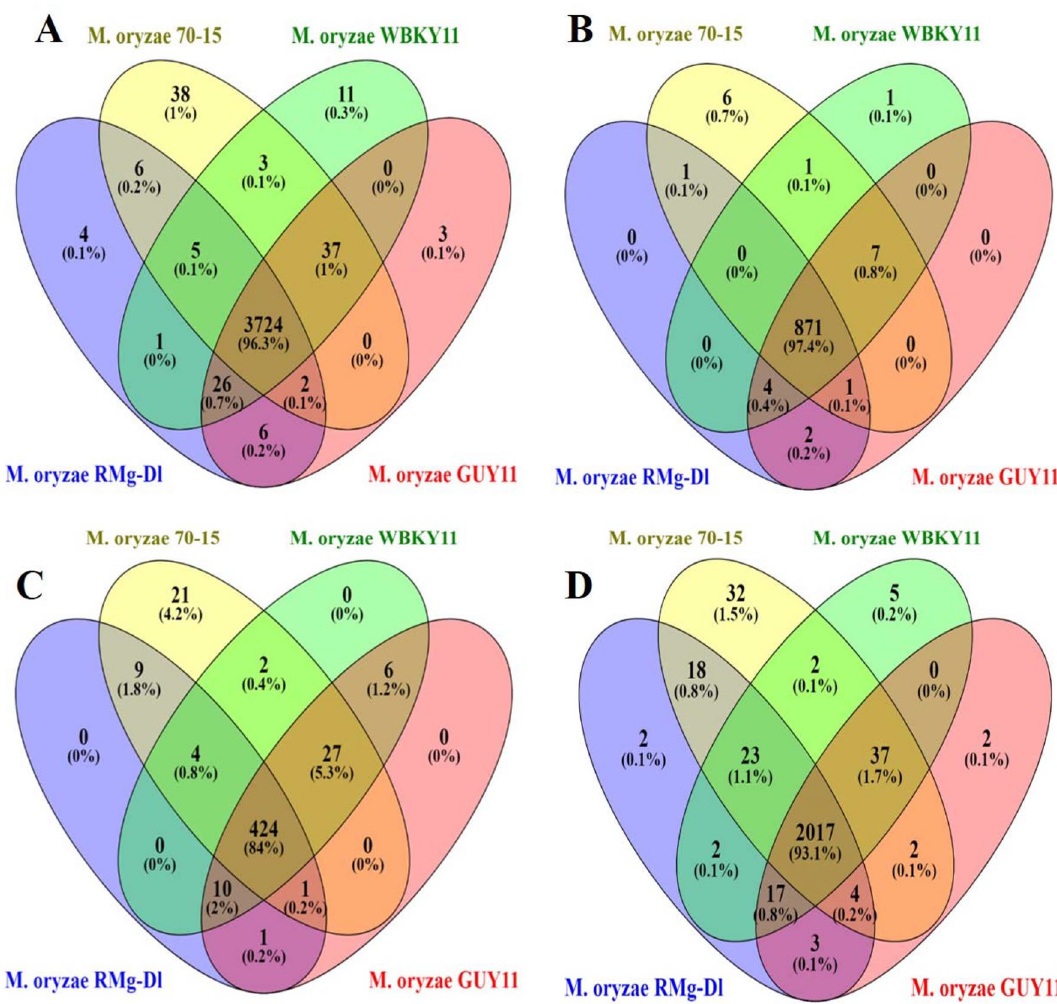
Figure 3. The predicted proteins InterProScan analysis of M. oryzae RMg_Dl, M. oryzae 70-15, M. oryzae WBKY11 and M. oryzae GUY11 genomes. The figure A , B , C and D shows the analyses against PFAM, superfamily, PIRSF and CDD databases,